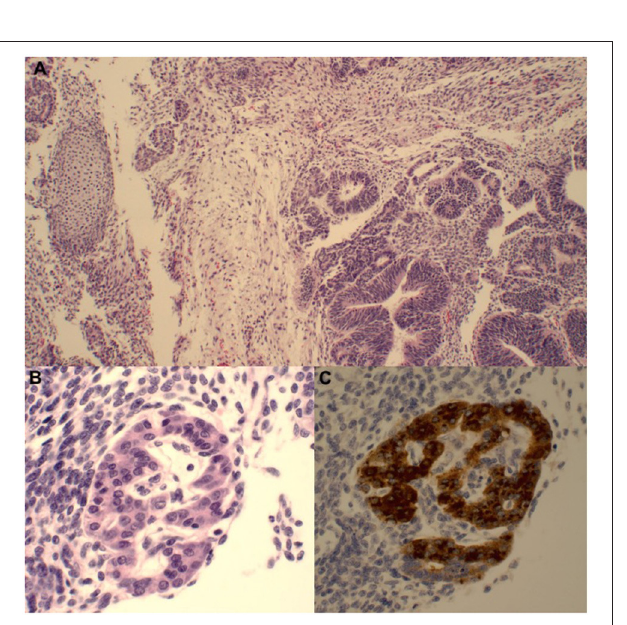
FIGURE 2 | (A) The majority of the tumor comprises immature teratoma with a predominance of primitive neuroepithelium (bottom right) and a smaller primitive mesenchymal component (nodule of immature cartilage on the left). (B) There were rare small foci of yolk sac tumor with primitive glandular structures as well as a hepatoid focus demonstrating cords of immature cells with more abundant eosinophilic cytoplasm and occasional small nucleoli. (C) This focus is strongly AFP-positive.